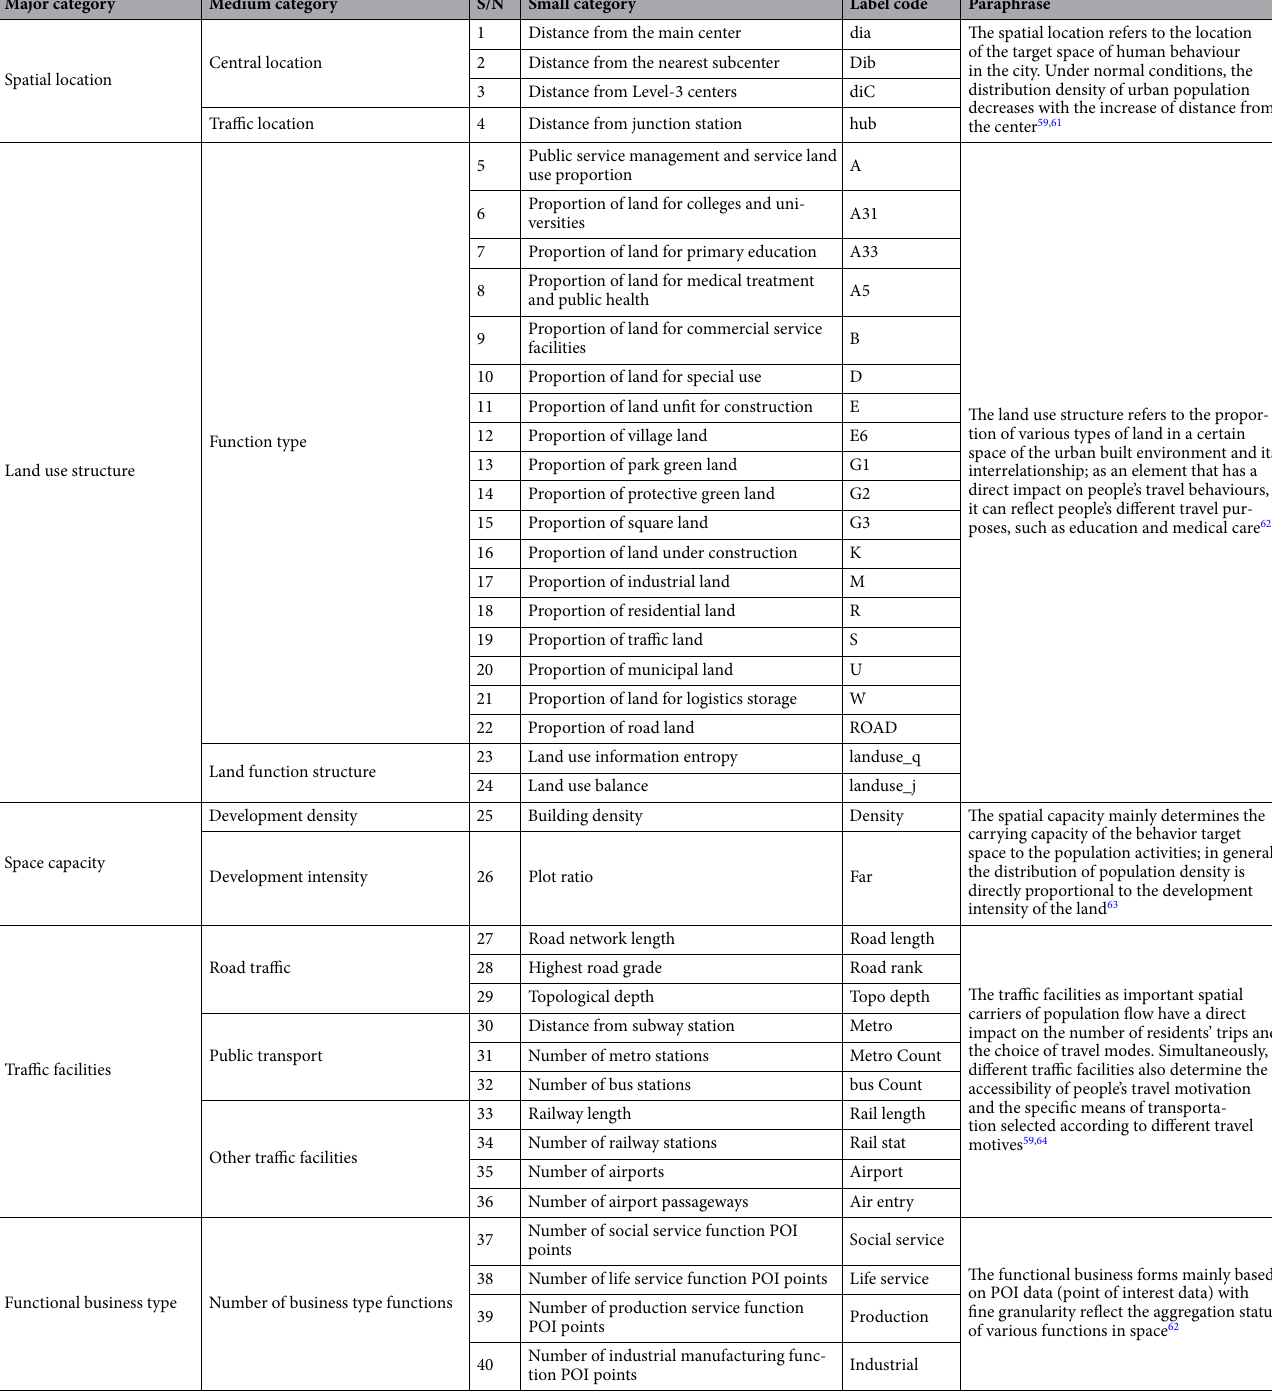
Table 1. List of impact indicators of urban built environment on population spatial–temporal distribution. Source Author